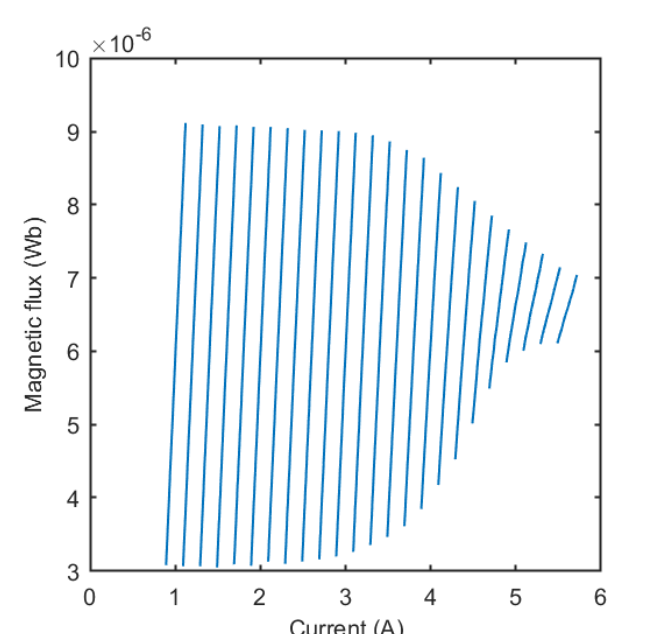
Figure 2. Average Φ( i L ) characteristics obtained for each measured output current value. The mag- Figure 2. Average Φ ( i L ) characteristics obtained for each measured output current value. The netic flux of each section is defined minus a constant term. magnetic flux of each section is defined minus a constant